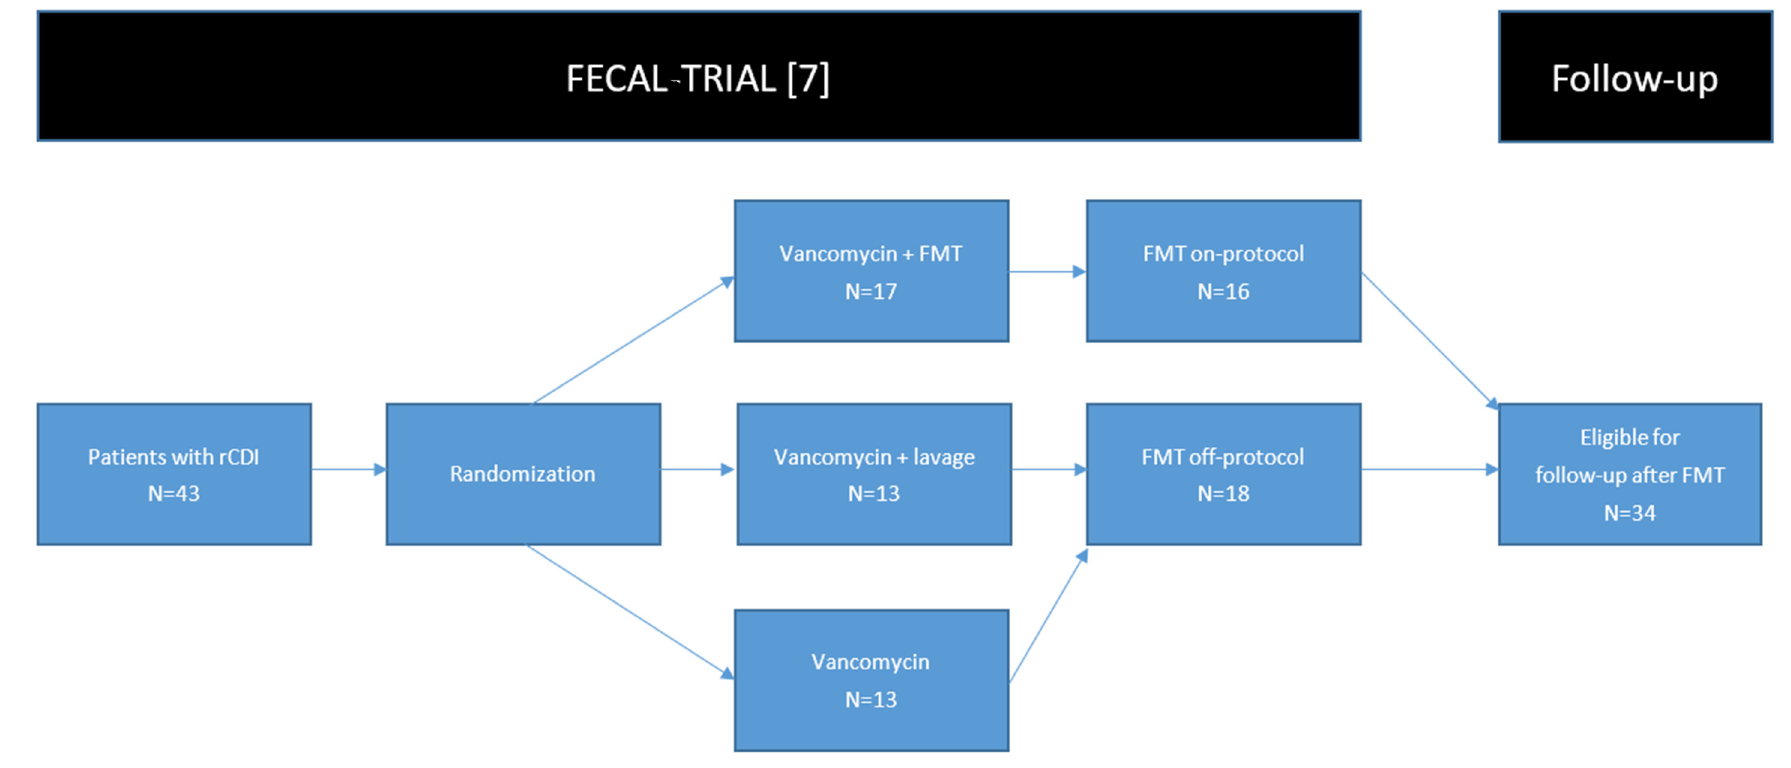
Figure 1. A flowchart of inclusion of patients. One patient randomized to receive FMT dropped out of the trial before receiving FMT, and was therefore not eligible for follow-up. Abbreviations: FMT: fecal microbiota transplantation, rCDI: recurrent Clostridioides difficile infection.